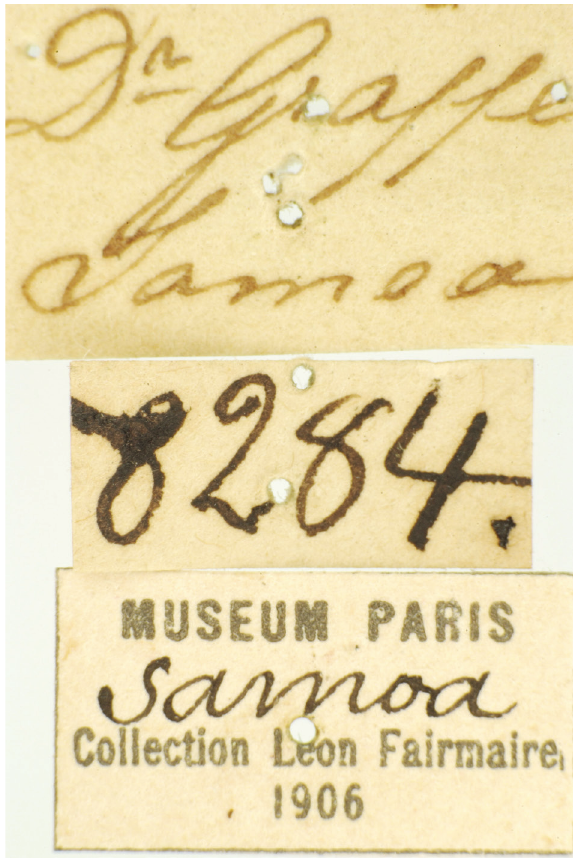
Figure 2. Specimen labels associated with holotype specimen of Bryanites graeffii